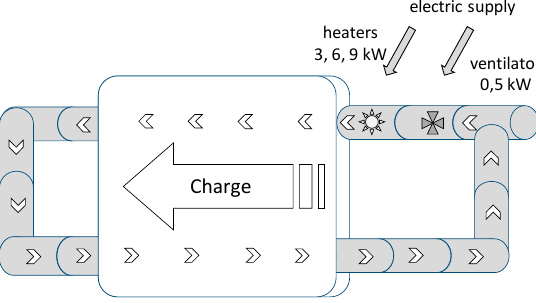
Figure 5. Charging the phase change material (PCM) accumulator in a closed distribution of a hot air.